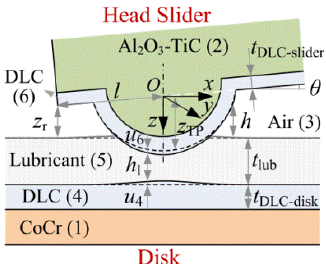
Figure 2. Illustration of the adhesive contact for the simplified HDI.